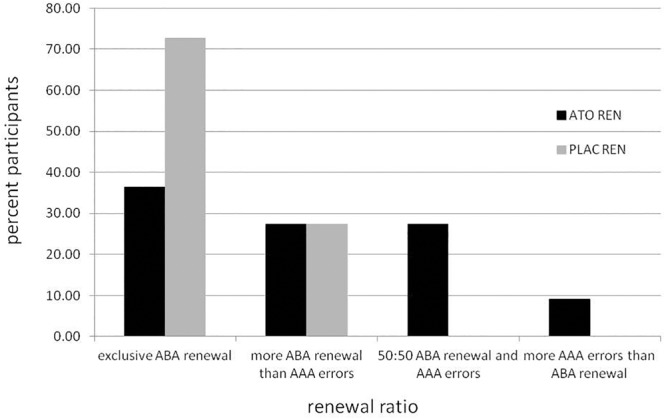
Percentage of participants in the ATO REN and PLAC REN groups exhibiting various combinations of ABA renewal and AAA errors.